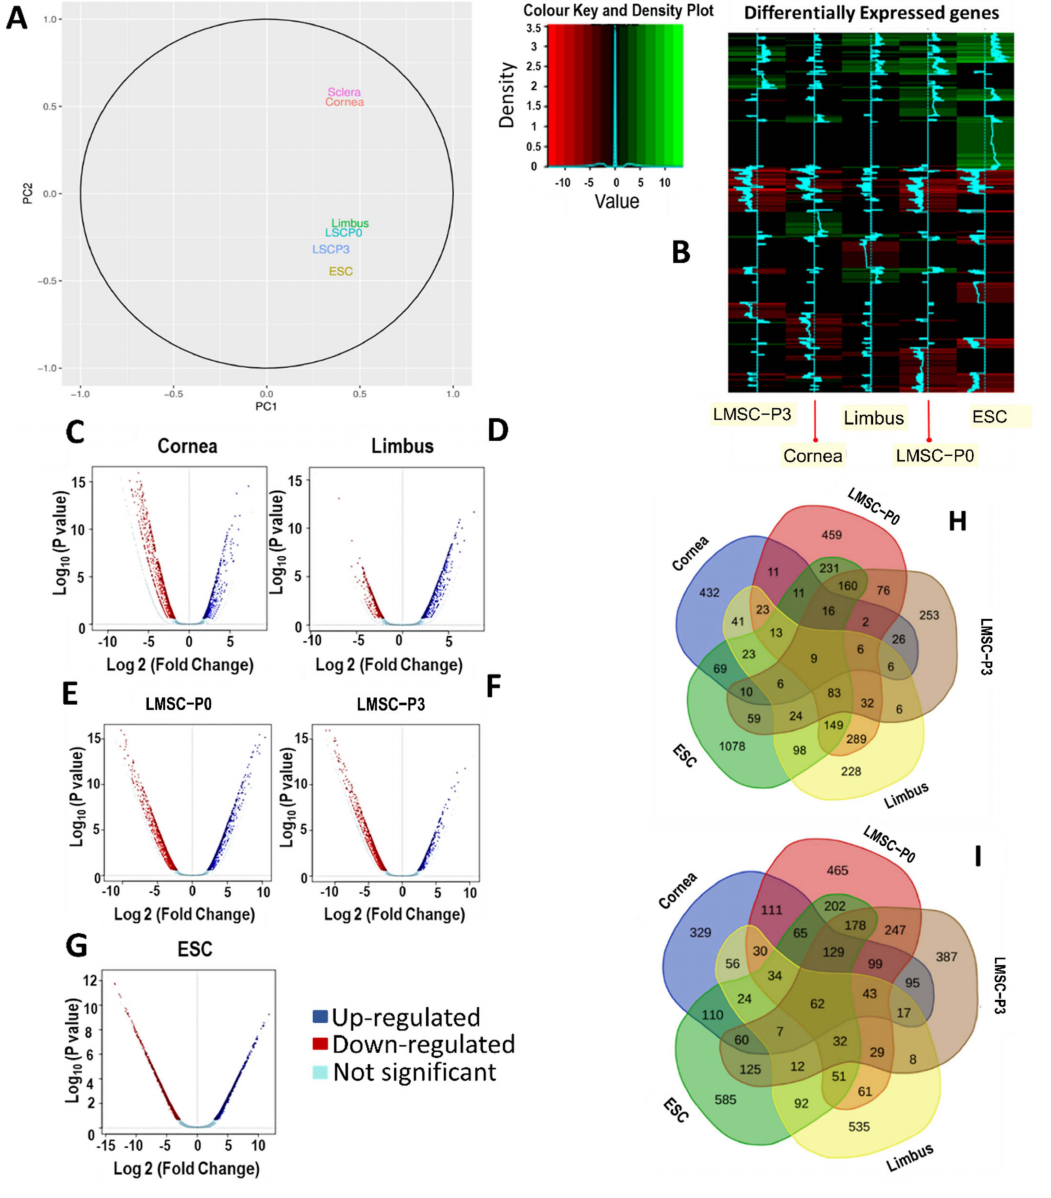
Figure 4. Similarities and asymmetry in the gene expression. ( A ) The count data from all the samples were transformed using Box-Cox transform to compensate for skewness before PCA analysis.